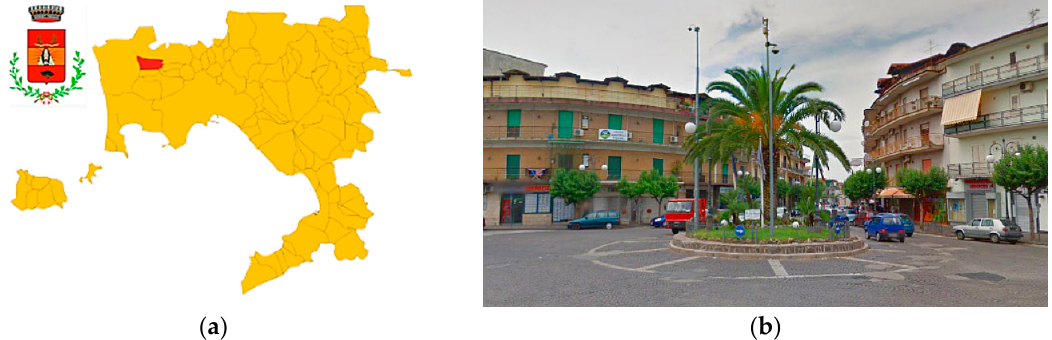
Figure 1. ( a ) Geographical location of Qualiano in the Campania region of Italy; and, ( b ) street view of one of the main city square.